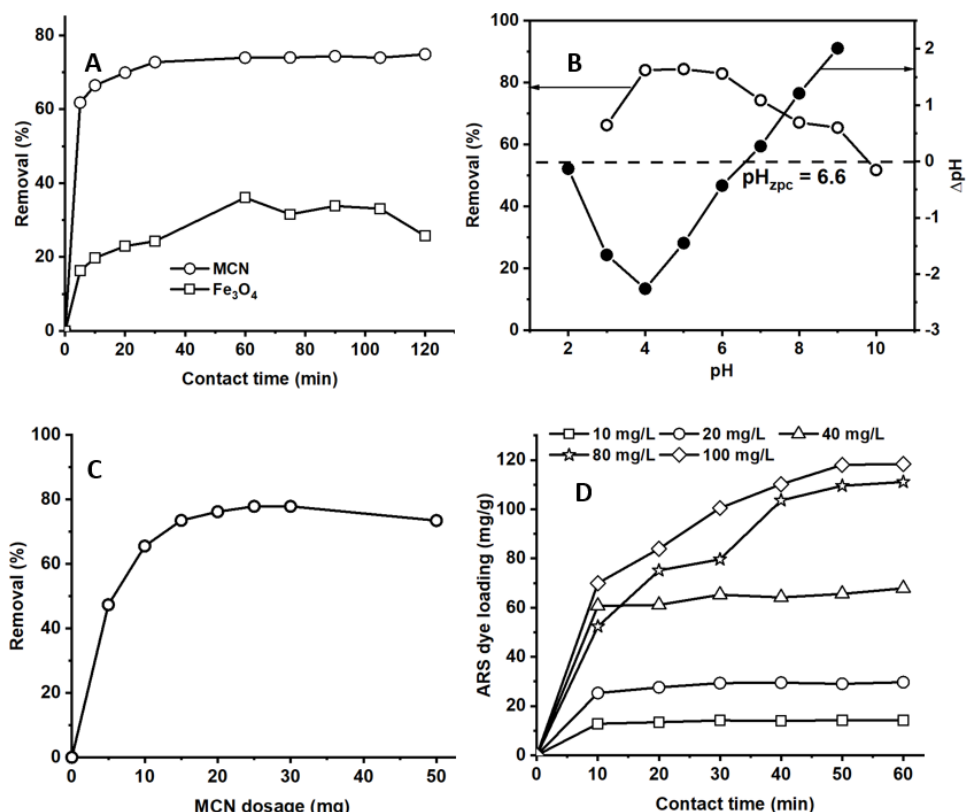
Figure 3. ( A ) Adsorption of the ARS dye onto MCN and Fe 3 O 4 nanoparticles